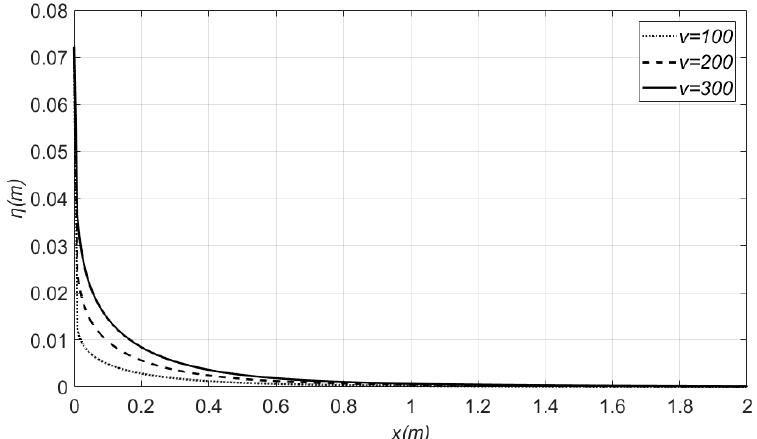
Figure 10. Free-surface elevations on the wall for different normalized wave impact velocities, at t = 0.01 s and fixed air cavity position − 1 ≤ z cavity ≤ −